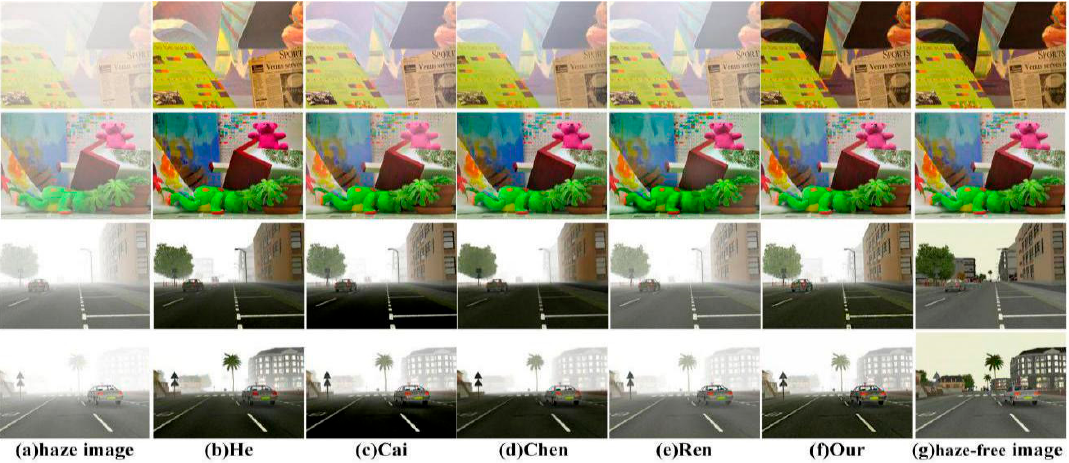
Figure 13. A comparison of synthetic images.